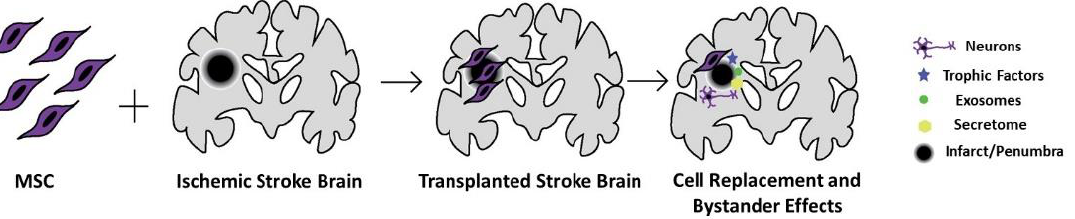
Figure 1. MSC grafts in the ischemic stroke brain. MSCs may migrate and repopulate the stroke brain, differentiate to neural cells and release trophic and anti-inflammatory factors and extracellular vesicles, altogether creating a secretome profile of a regenerative brain. While these may not fully repair the lost tissue, MSCs may be able to regenerate the spared tissue (i.e., penumbra and peri-infarct area) surrounding the necrotic infarct core and the adjacent penumbra or peri-infarct